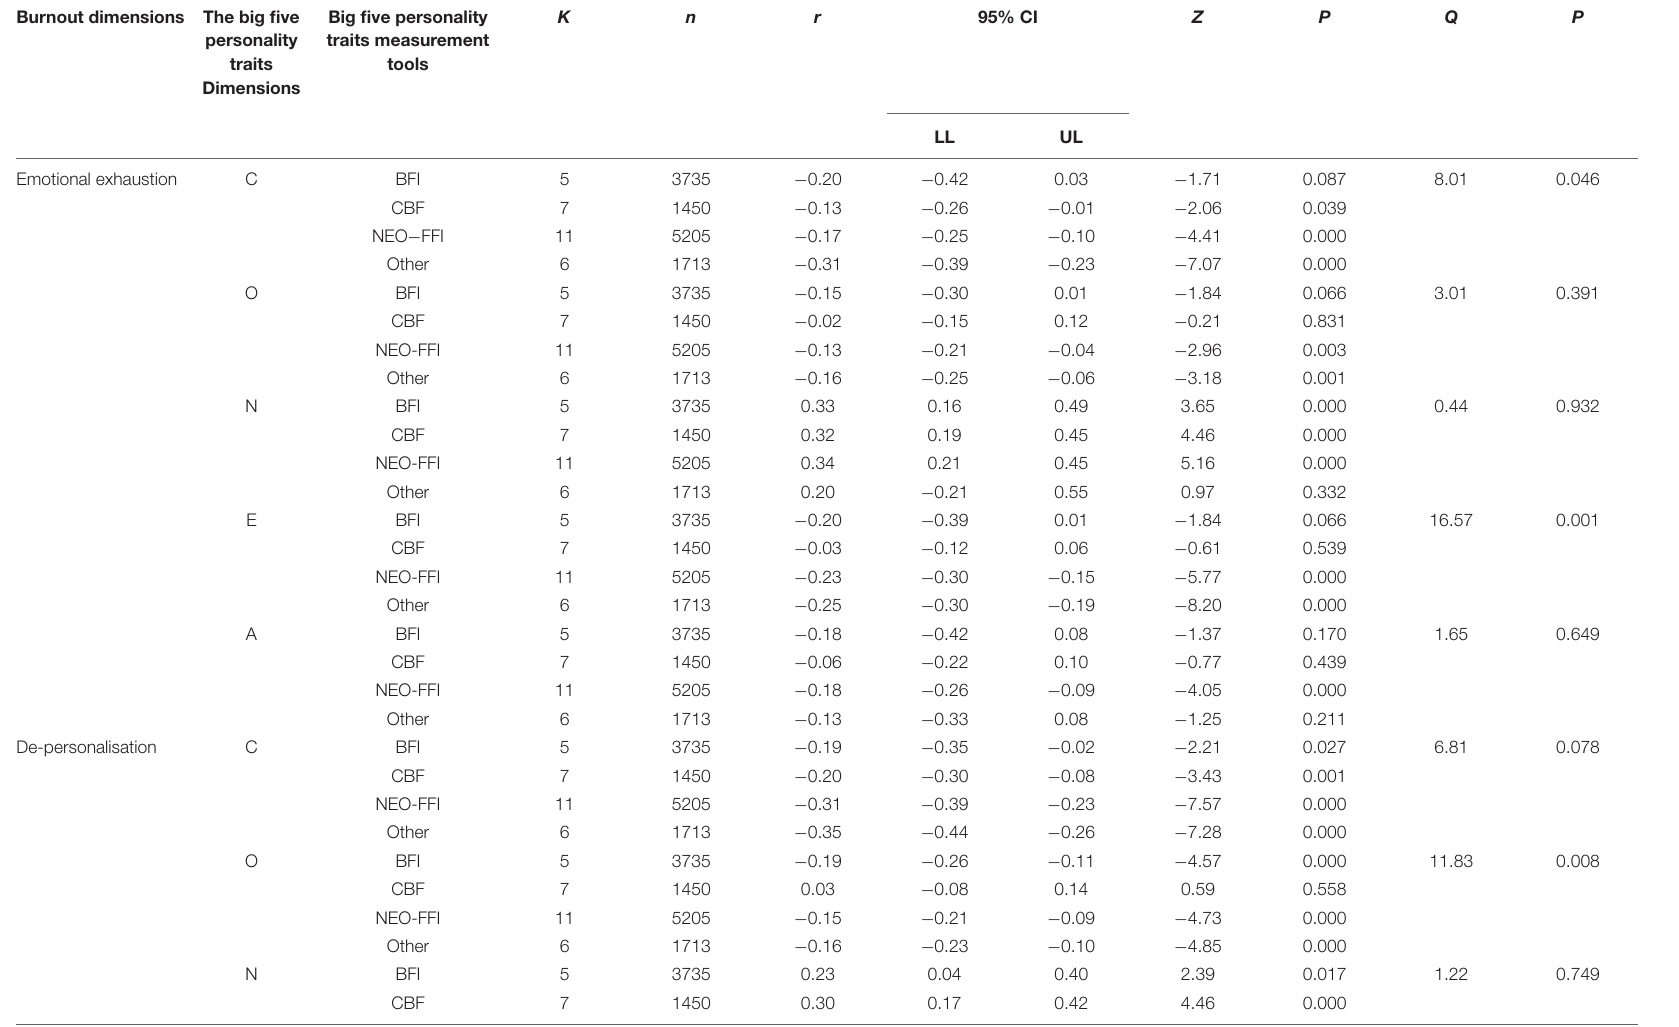
TABLE 7 | Moderating effects of big five personality traits measurement tools on the relationship between big five personality traits and job